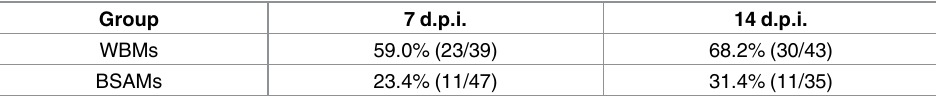
Table 2. Infection rate of ZIKV in Ae . aegypti receiving infectious blood meals and protein meals at 7 and 14